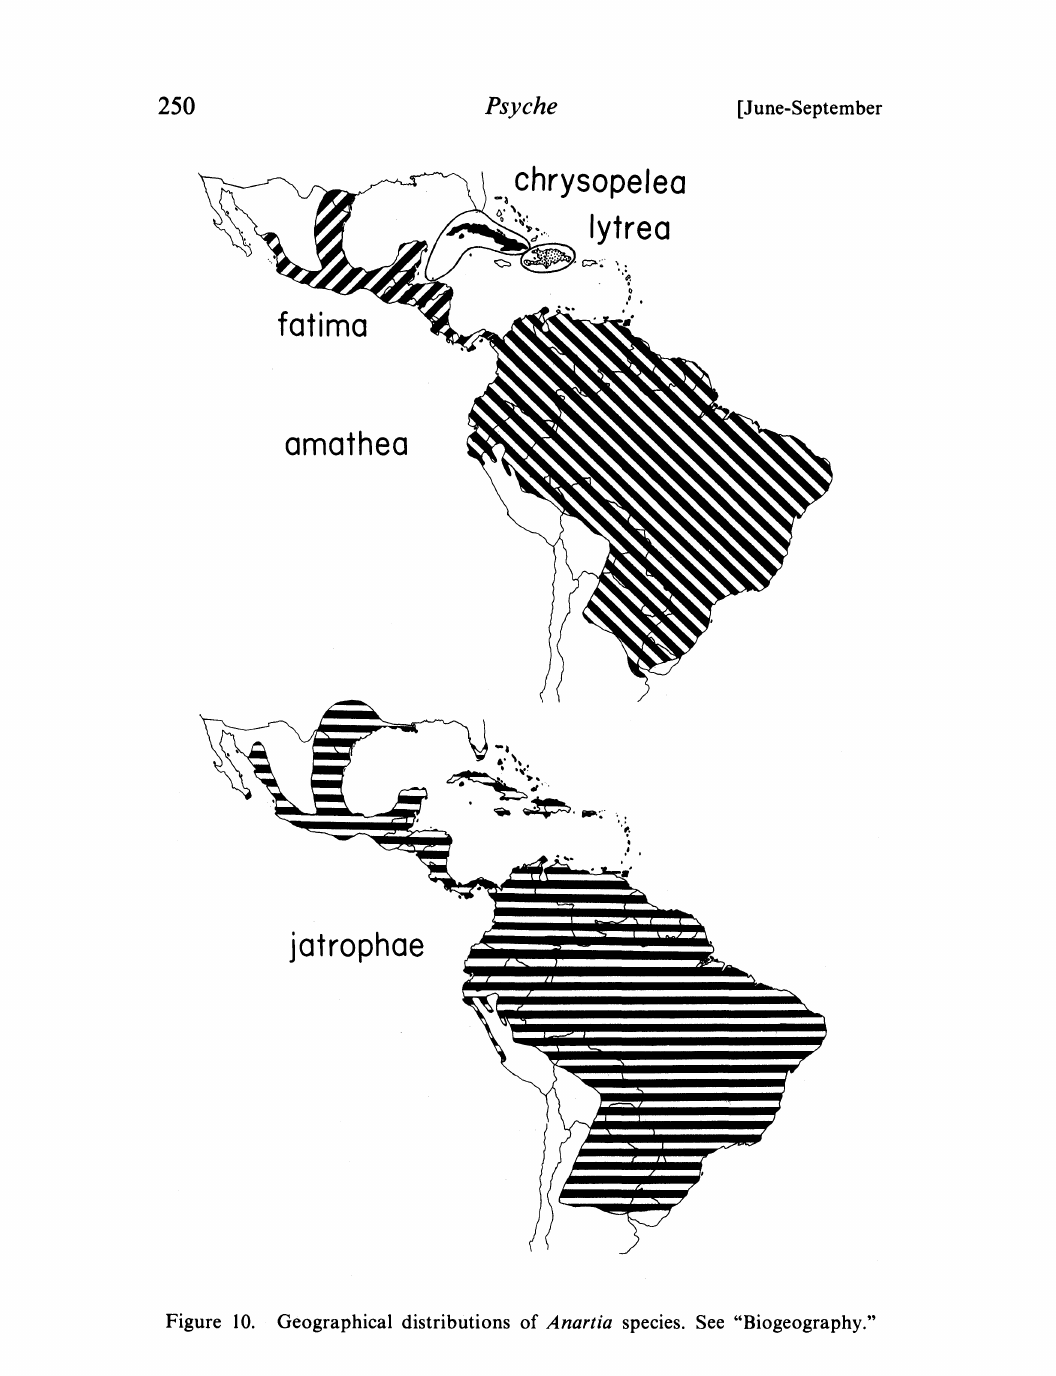
Figure 10. Geographical distributions of Anartia species. See